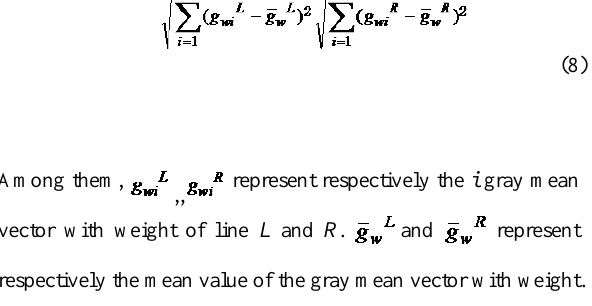
Fig.5 Straight Line Support Domain